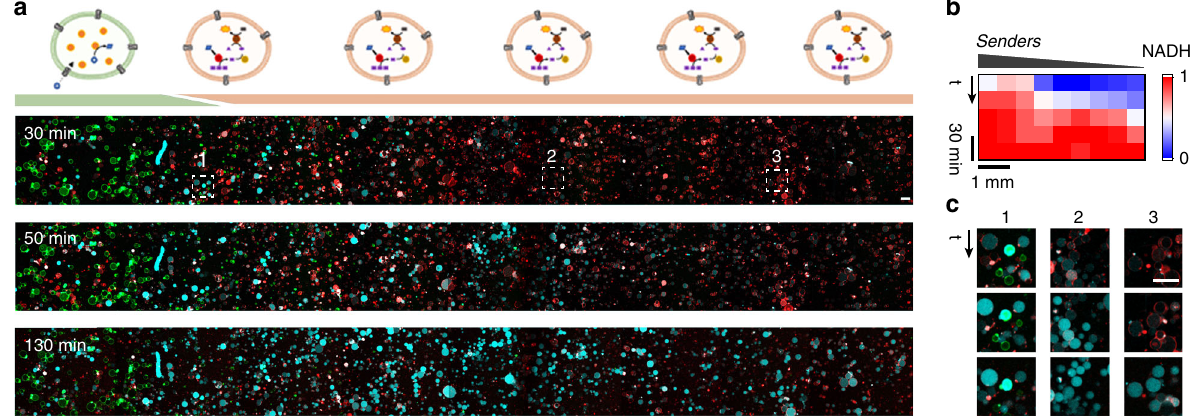
Fig. 5 Spatially propagating signalling fronts in communities of Senders and Receivers. a The Senders form a colony that was triggered by ATP to send an activation signal to the population of Receivers. From the cluster of Senders, a signalling front spread throughout the 5 mm long channel and activated the Receiver GUVs in a distance-dependent fashion. Overlay of NADH (cyan), Sender GUVs (green), Receiver GUVs (red). Scale bars represent 50 µ m. b Kymogram of the activation of the Receivers by the signalling front, as measured by the relative NADH fl uorescence throughout the channel at various time points. c Individual GUVs from the positions marked in ( a ), which demonstrate the distance-dependent activation of the Receivers.